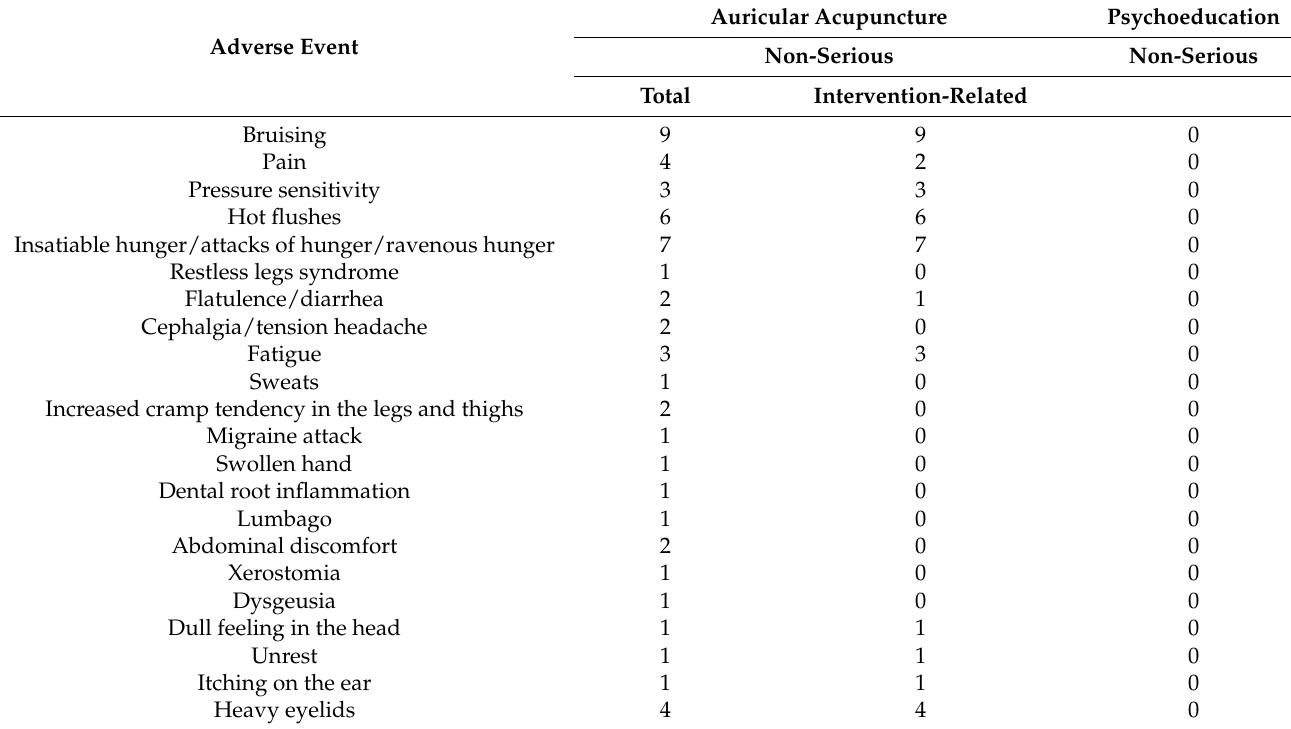
Table 4. Number of adverse events listed by treatment